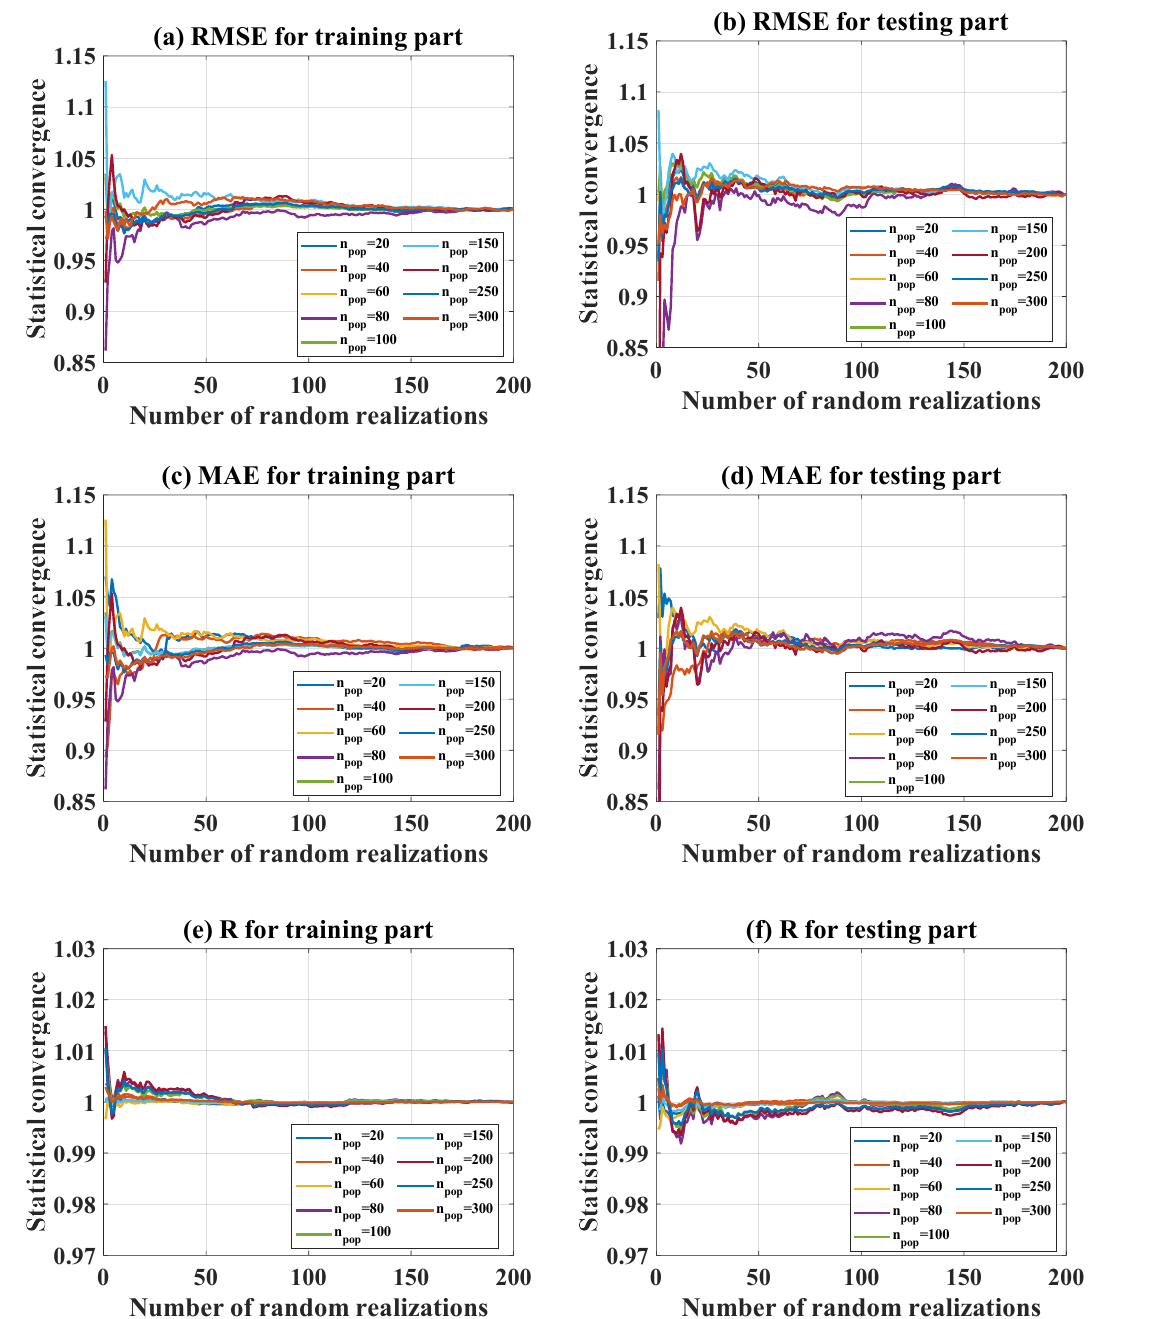
Figure 7. Statistical convergence over 200 random realizations in terms of n pop for the training part: ( a ) RMSE, ( b ) MAE, ( c ) R. Statistical convergence over 200 random realizations in terms of n pop for the testing part: ( d ) RMSE, ( e ) MAE, ( f ) R.